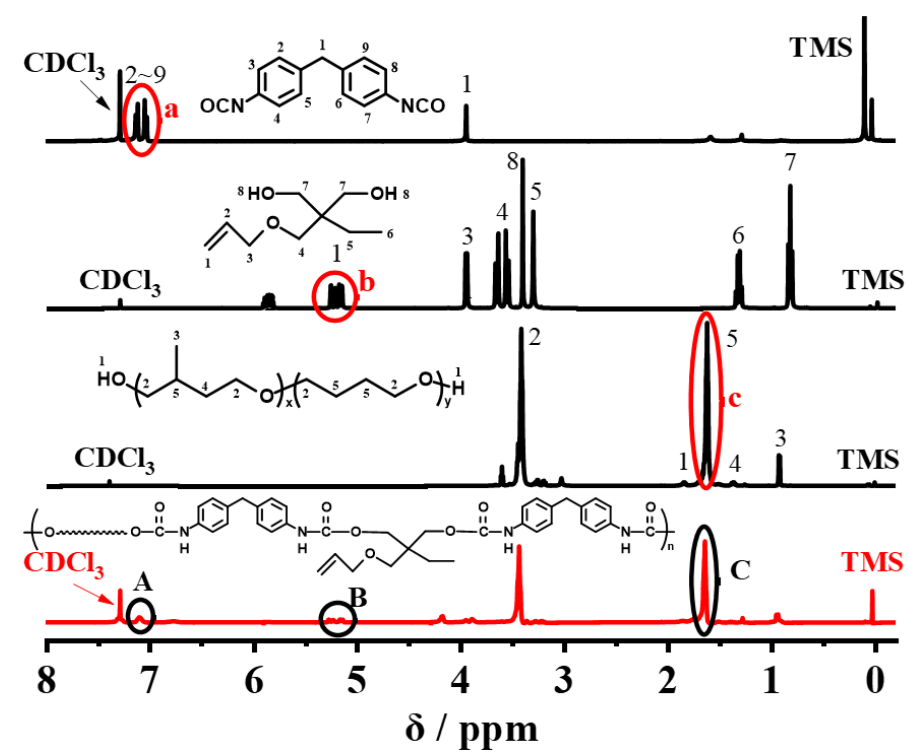
Figure 3. 1 H NMR spectra of 3MCPG, MDI, TME, and raw MPU rubber. Furthermore, in the 1 H NMR spectrum of raw MPU rubber, peak A ( δ = 7.03–7.14 ppm) corresponds to the protons on the benzene ring of raw MPU rubber. Several other characteristic peaks overlap with the solvent (CDCl 3 ) peak. Peak B ( δ = 5.12–5.28 ppm; –CH=) corresponds to the protons of the C=C double bond in raw MPU rubber, and peak C ( δ = 1.60–1.71 ppm; –CH 2 –) corresponds to the protons on the methylene group not con ‐ nected to the oxygen atom in the molecular chain of 3MCPG. These results confirm that